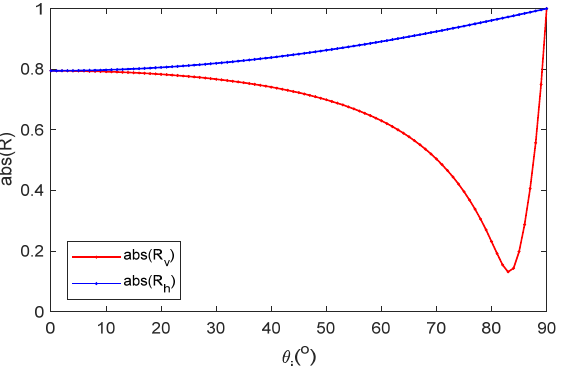
Figure 2. Reflection coefficient vs. incident angles for two polarizations. The blue line represents horizontal polarization. The red line represents vertical polarization ( 𝑇 (cid:3404) 20 ℃ , 𝑆 (cid:3404) 30 psu , 𝑓 (cid:3404) 7.8 GHz ).